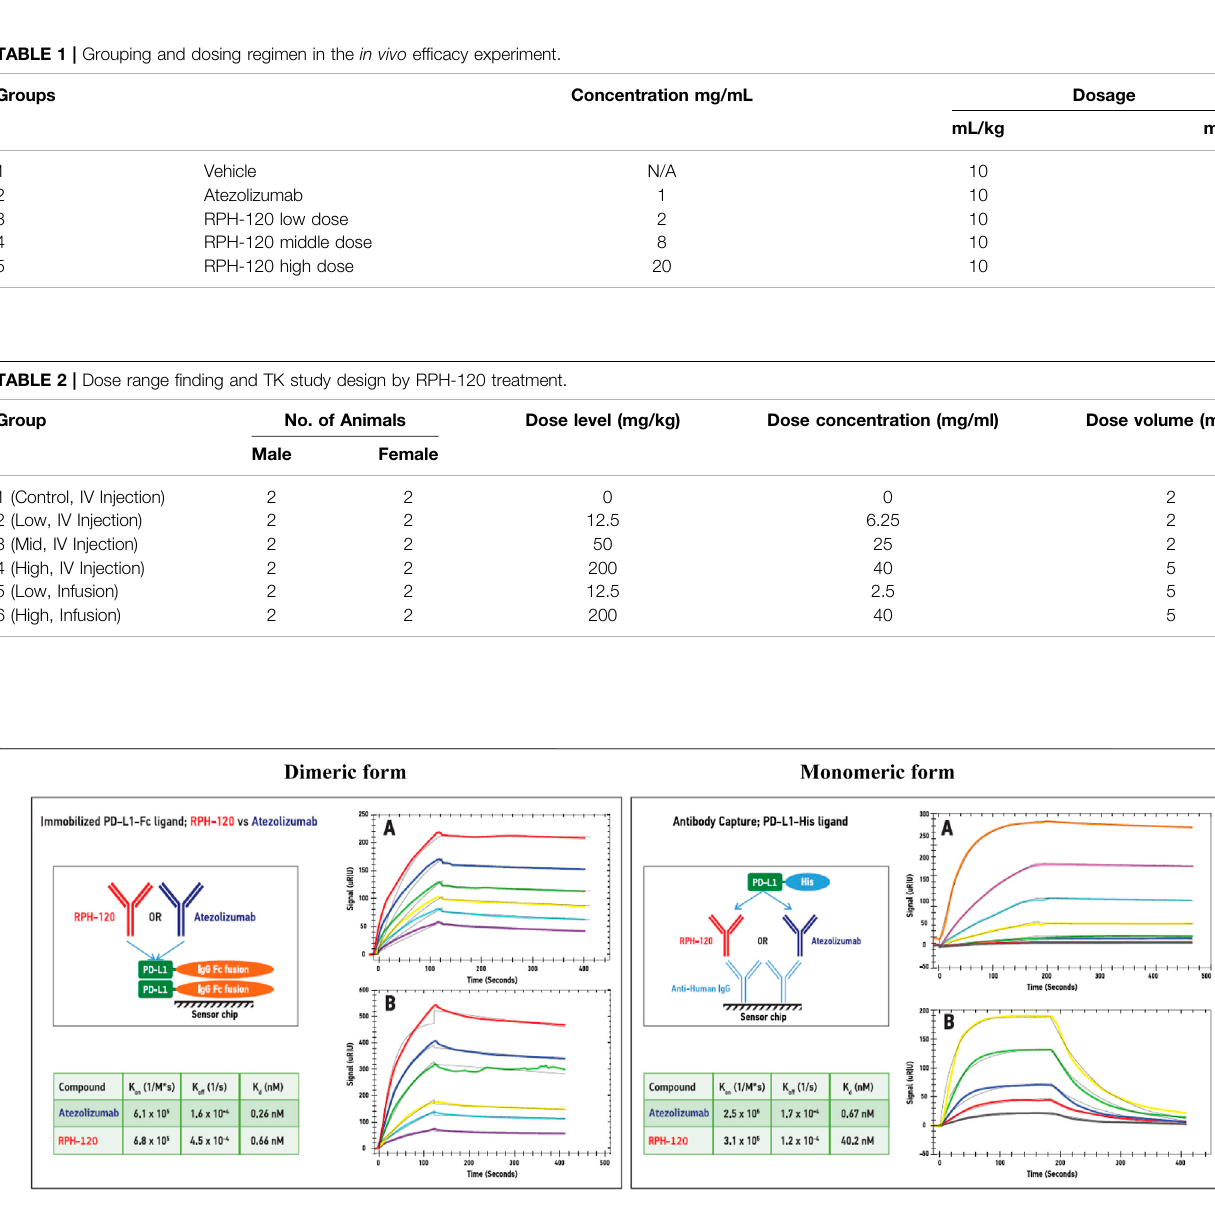
FIGURE 1 | SPR analysis of the RPH-120 or atezolizumab binding parameters to dimeric or monomeric forms of human PD-L1: Schematic presentation of alternative capturing approaches. Dimeric form: PD-L1-Fc fusion protein was immobilized on a CM5 sensor chip, then series of SPR sensograms of binding of either RPH-120 or atezolizumab at various concentrations, were generated. Monomeric form: Anti-human capturing antibodies were immobilized on aCM5 sensor chip,then RPH-120 or atezolizumab were loaded on the capturing antibodies followed by various concentrations of monomeric (PD-L1-His) tagged protein. Series of sensograms of binding of the monomeric form were generated and analysed.Panels A – Aatezolizumab; Panels B – RPH-120.